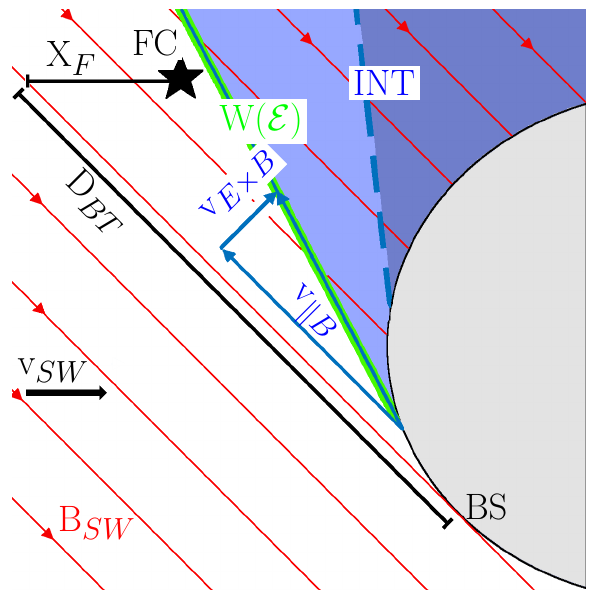
Fig. 4. A section through the bow shock (marked BS) in a plane containing the IMF vector and the solar wind flow (B SW and v SW ). D BT is the distance along the tangent field line from the point of tangency to a point immediately upstream of the observation point. X F is the distance, in the direction of the solar wind flow, from that upstream point to the event location. In this plane, an event (here a foreshock cavity labelled FC) may be located by the coordinates X F and D BT . It is only possible for particles of a given energy to access regions downstream of the boundary line marked W ( E ) as they are subjected to E × B drift in the solar wind motional electric field (see Schwartz et al., 2000a). W ( E ) is the upstream edge of the ion beam foreshock. This and other boundaries of the ion-foreshock (e.g. the intermediate foreshock boundary of Meziane and d’Uston (1998), labelled INT) lie downstream of the tangent field line.